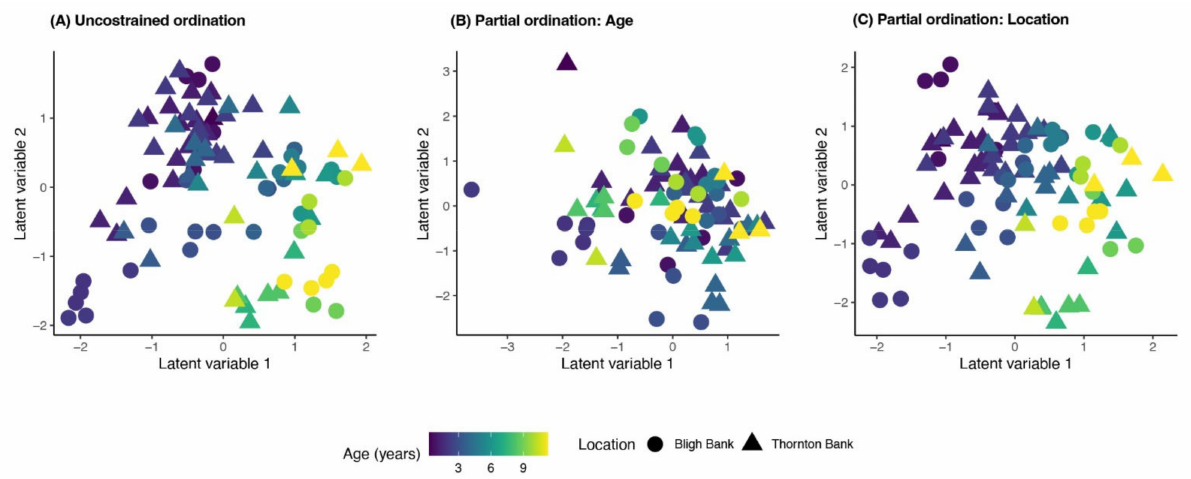
Figure 2. Graphical representation of the model-based ordinations derived from generalized linear latent variable models describing changes in assemblage structure across samples from Bligh Bank (circle) and Thornton Bank (triangle) and over time. The top left panel ( A ) shows the unconstrained ordination describing the general variation of the assemblage data. The top right ( B ) and bottom left ( C ) are partial ordinations describing the variation in assemblage data after adjusting for the effect of the environmental explanatory variables age and location. The more the patterns differ from the unconstrained version, the more the variation in assemblages is explained by the constraining explanatory